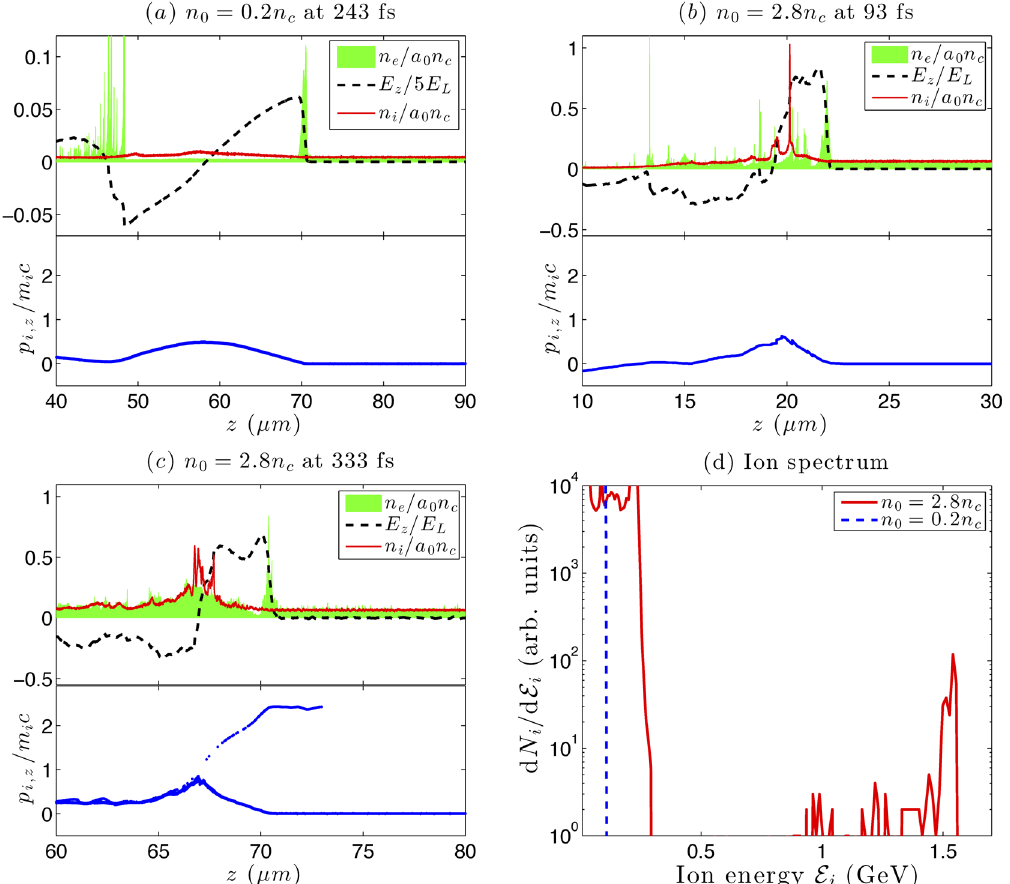
FIG. 1. Results of 1D-PIC simulations. A laser pulse of amplitude a 0 ¼ 44 (not shown) is incident from the left, driving a wakefield. Electron and ion densities as well as electric field are plotted for two different initial plasma densities: (a) 0 . 2 n c , (b) and (c) 2 . 8 n c ; lower parts show ion phase space in blue. Results in (b) refer to an early time (93 fs), when the ion wave is just before breaking, while those in (c) refer to a later time (333 fs), when the ion wave is broken and accelerated ions have overtaken the electron layer at the laser front; (a) corresponds to a linear ion wave developing at low plasma density; (d) ion energy spectra corresponding to (c) and